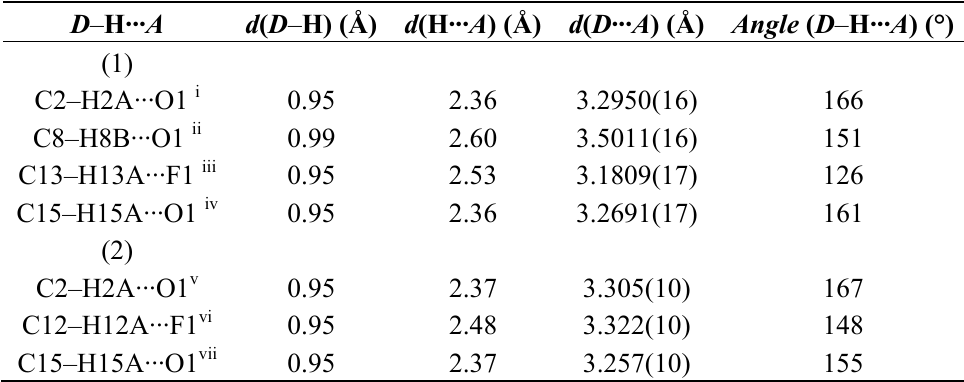
Table 2. Hydrogen bond geometries for compounds ( 1 ), ( 2 ), ( 3 ) and ( 4